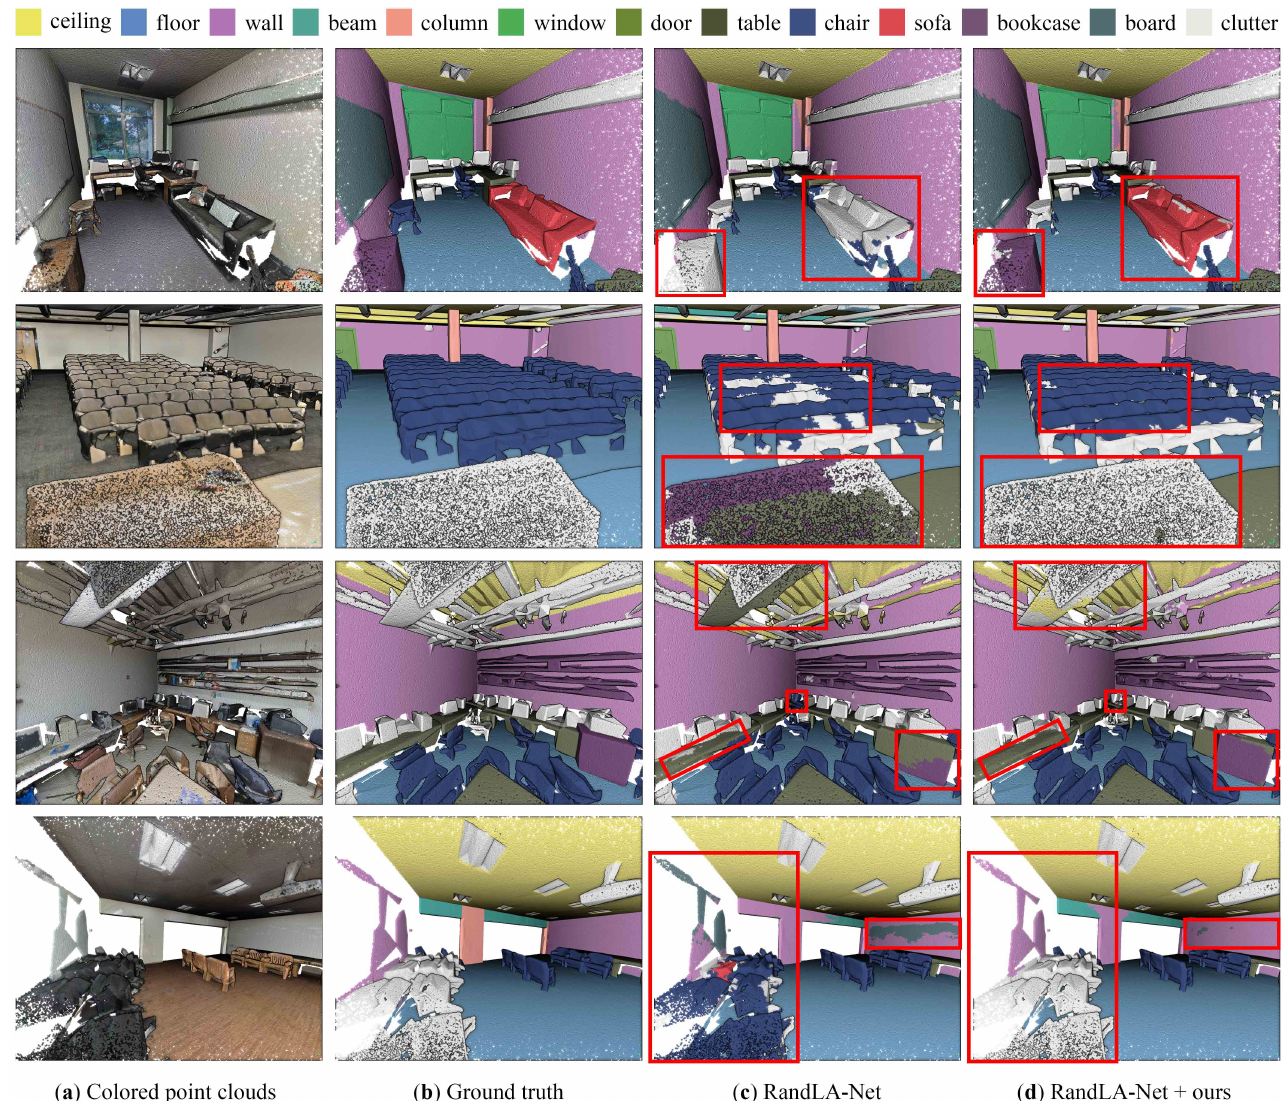
Figure 5. Qualitative comparison between the semantic segmentation results of RandLA-Net [20] and ours on the S3DIS dataset [24]. The red rectangles highlight the major differences between the results of RandLA-Net and ours. Table 4. Quantitative comparison between the semantic segmentation results of PointNet [7],